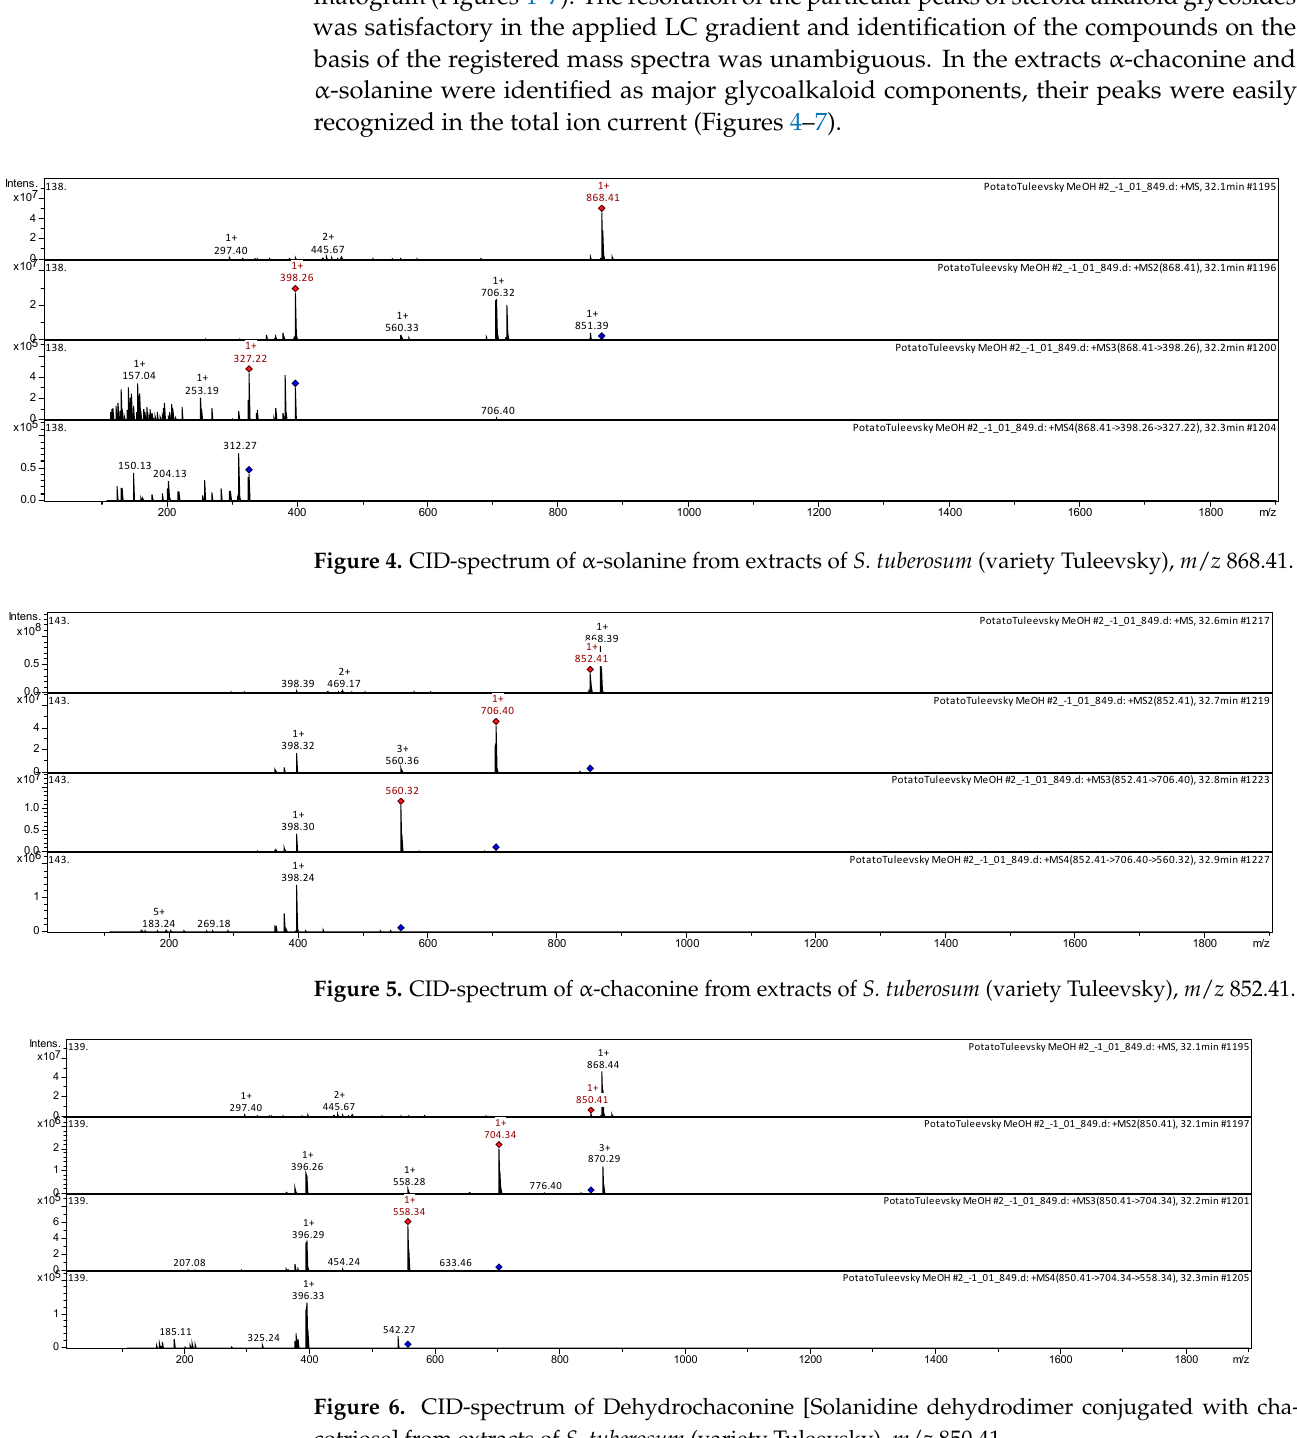
Figure 7. CID-spectrum of Leptinine II from extracts of S. tuberosum (variety Tuleevsky), m / z 884.34. Figure 4 shows an example of decoding the spectrum of the steroidal alkaloid α - solanine from an ion chromatogram obtained by tandem mass spectrometry. The [M + H] + ion produces four product ions at m / z 398.26, m / z 560.33, m / z 706.32, and at m / z 851.39 (Figure 4). A fragment ion at m / z 398.26 gives rise to three daughter ions at m / z 327.22, m / z 253.19, and m / z 157.04. A fragment ion at m / z 327.22 gives rise to three daughter ions at m / z 312.27, m / z 204.13, and m / z 150.13. This compound is identified in scientific articles as α -solanine, for example in S. tuberosum [8,13–15]. Figure 5 shows an example of decoding the spectrum of the steroidal alkaloid α - chaconine from an ion chromatogram obtained by tandem mass spectrometry. The [M + H] + ion produces three product ions at m / z 706.4, m / z 560.36, and at m / z 398.32 (Figure 5). A fragment ion at m / z 706.4 gives rise to two daughter ions at m / z 560.32, and m / z 398.3. A fragment ion at m / z 560.32 gives rise to three daughter ions at m / z 398.24, m / z 269.18, and m / z 183.24. This compound is identified in scientific articles as α -chaconine, for example in S. tuberosum [8,13–15]. In the mass spectra [M + H]+ ions at m / z 868 and 884 were observed. Four additional peaks of triglycosides described by us, as glycosidic conjugates of dehydrosolanidine were also identified, their protonated molecular ions [M + H] + were detected at m / z 850 and m / z 866, respectively (Figures 5–7). In the mass spectra of all triglycosides [M + H] + ions and fragments were observed, formed after consecutive cleavage of glycosidic bonds between sugars and sugar and aglycone. In the first step of the fragmentation pathway of studied compounds (Figures 4–7) cleavage of both sugar rings on the nonreducing end was observed. In the mass spectra of steroid alkaloid glycosides linked with solatriose in the first step of fragmentation elimination of glucose ([M + H] + − 162) or rhamnose ([M + H] + − 146) was recorded. Due to simultaneous co-elution from LC column more than one secondary metabolite in the mass spectra were present but verification of the steroid alkaloid glycosides presence in the analyzed samples was possible. On the basis of single ion